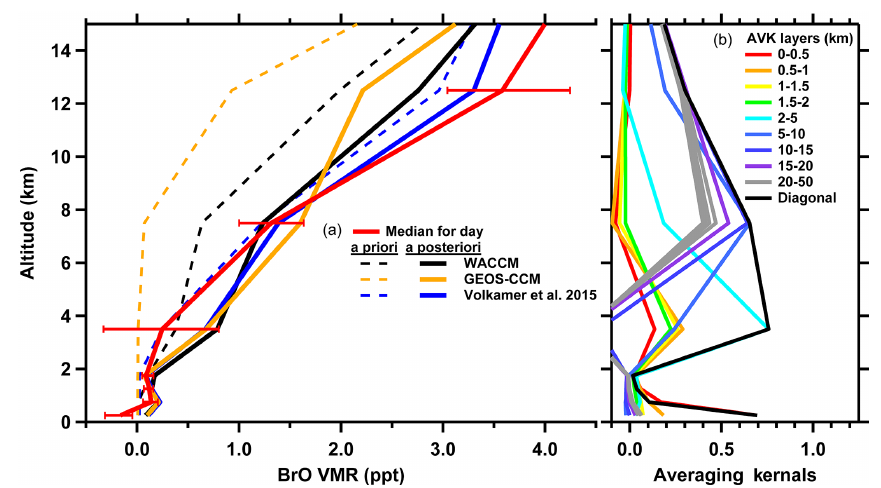
Figure 5. BrO profiles for a single MAX-DOAS measurement scan at SZA ∼ 23 ◦ around solar noon. Panel (a) contains three of the a priori profiles tested (dashed lines) and the respective a posteriori profiles (solid lines); colors correspond to use of WACCM (black), GEOS-CCM (orange), and TORERO RF12 (blue) as a priori information. Panel (b) contains the AVK from the inversion using the WACCM profile as the a priori, and gives an indication of the amount of information coming from the measurements as a function of